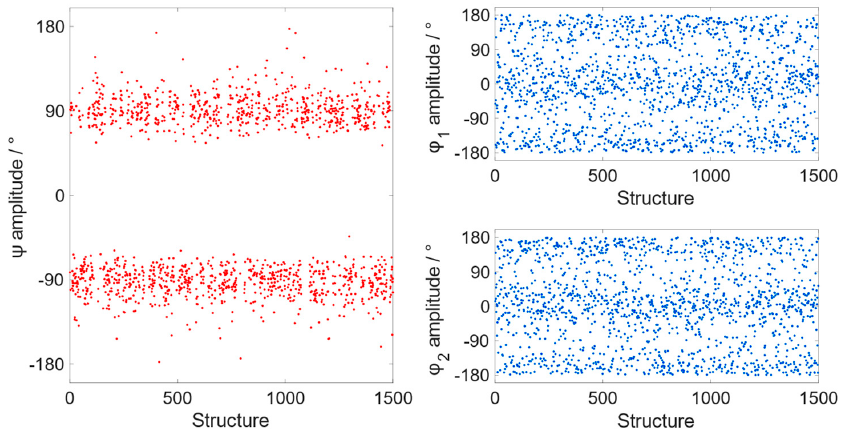
Figure 2. Values of the Ψ ( left ) and Φ 1,2 ( right ) dihedral angles for the structures extracted from the MD